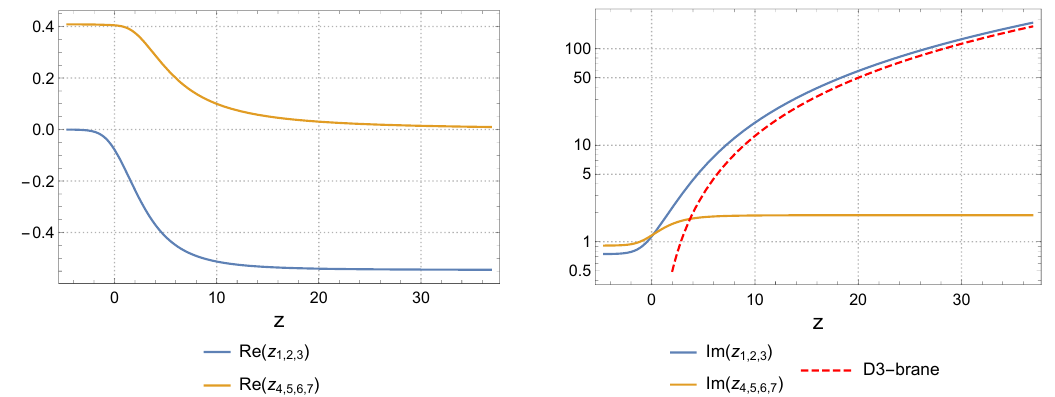
Figure 3 . Holographic RG flow from N = 4 SYM 4 (UV, right) to N = 1 & SU (3) J-fold CFT 3 (IR, left) with Λ = − 1 and λ = − 0 . 16